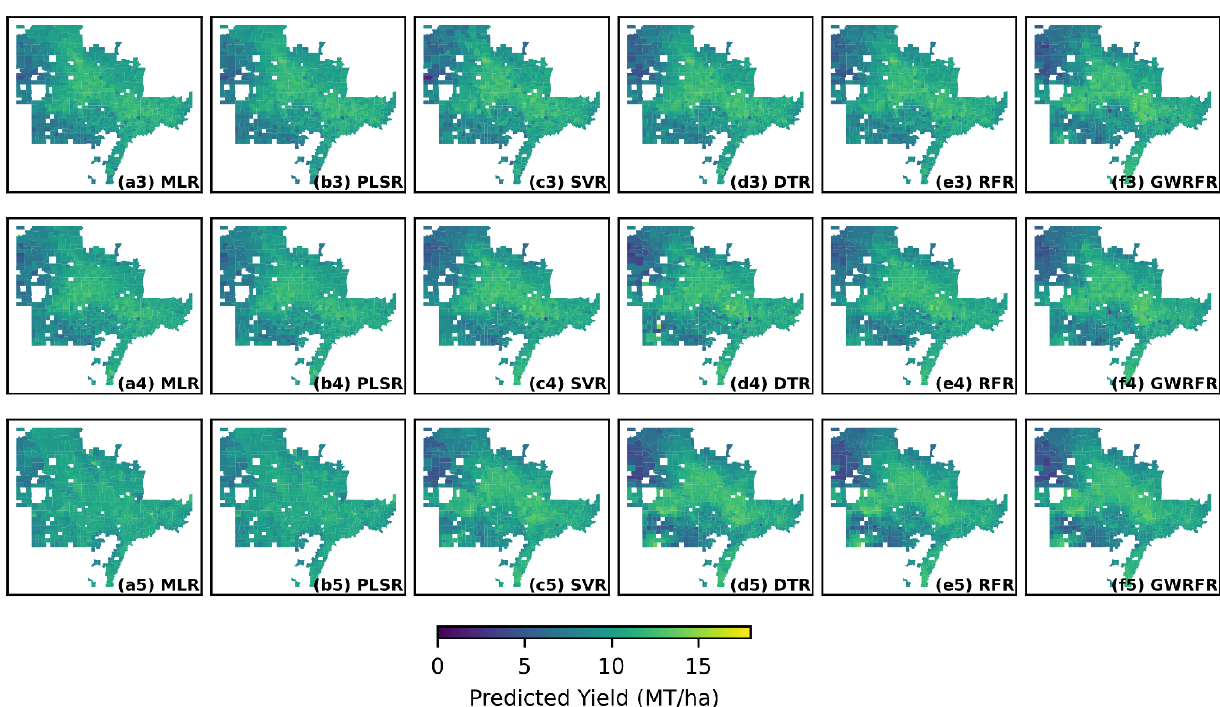
Figure 4. The spatial distribution of predicted yield of ( a ) MLR, ( b ) PLSR, ( c ) SVR, ( d ) DTR, ( e ) RFR, and ( f ) GWRFR using (1) full-length features, (2) vegetation indices derived from RS data, (3) GPP, (4) climate data, and (5) soil data.